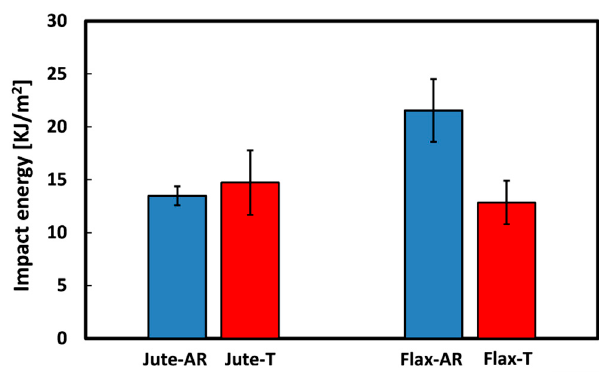
Figure 8. Impact energy of monolithic laminates. Table 3. Impact properties of laminates.